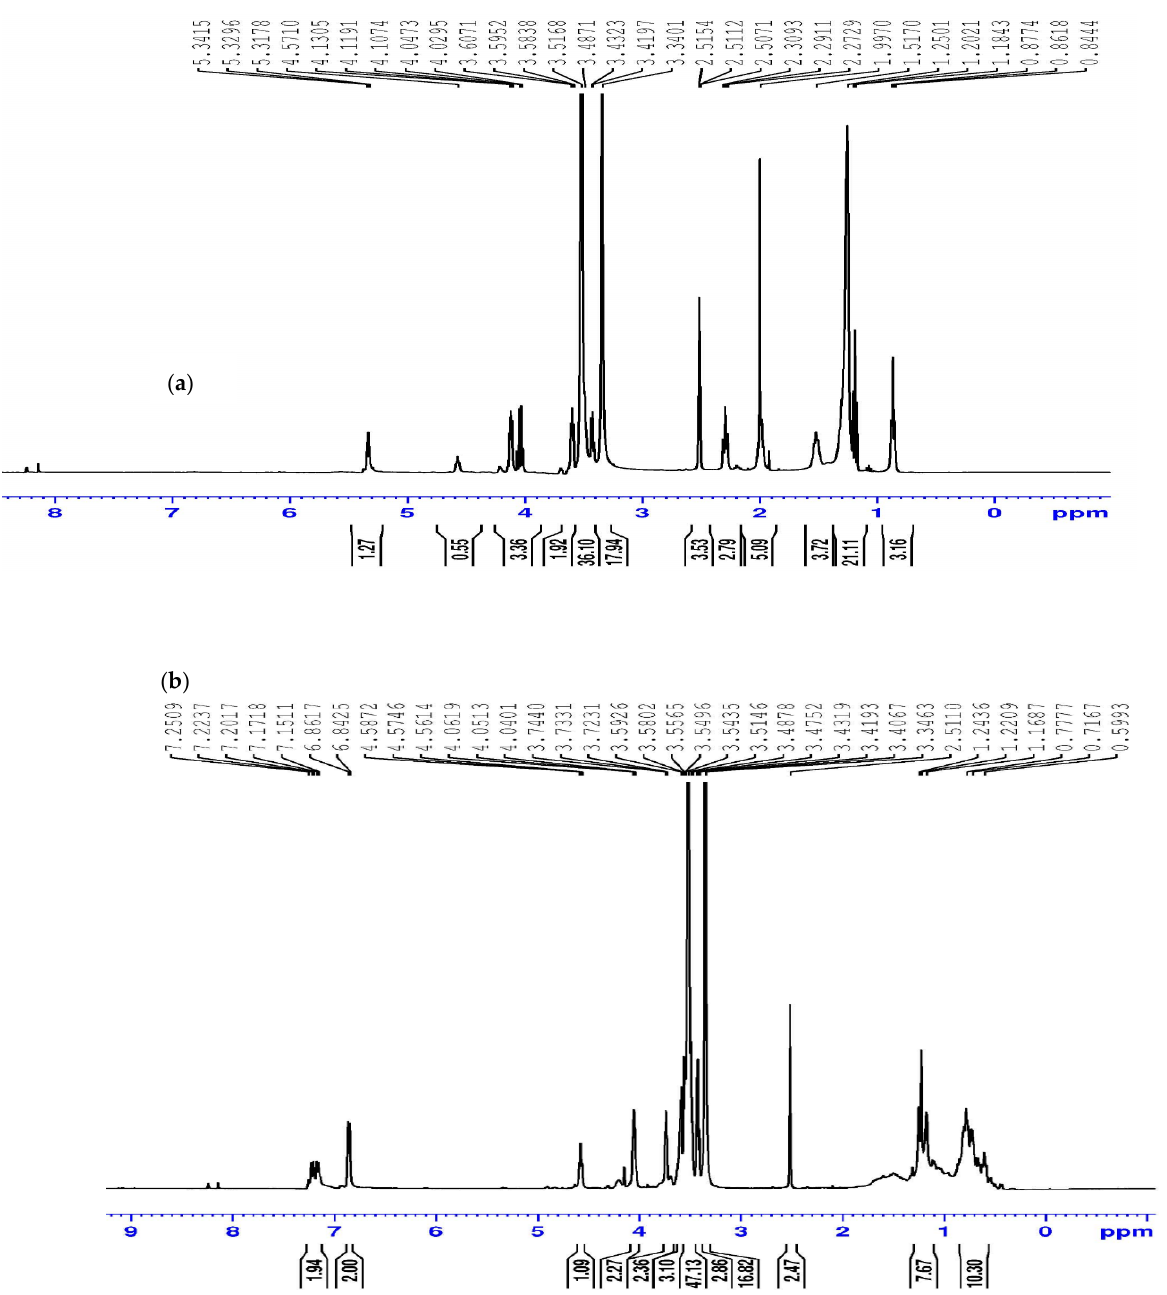
Figure 8. 1HNMR of ( a ) Scale inhibitor OAE, ( b ) Scale inhibitor DPE.